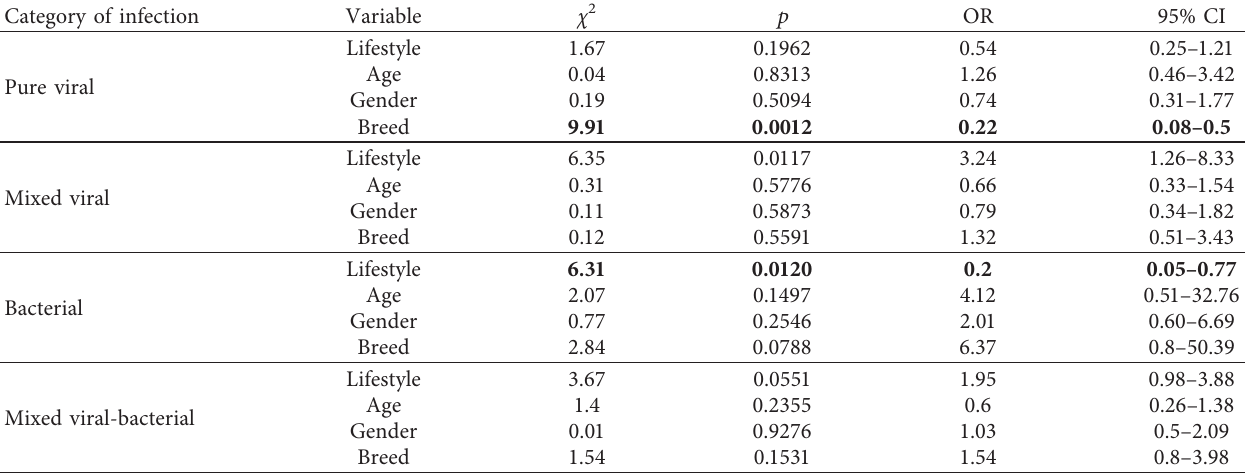
Table 3: Correlation of the categories of infection to lifestyle, age, gender, and breed.